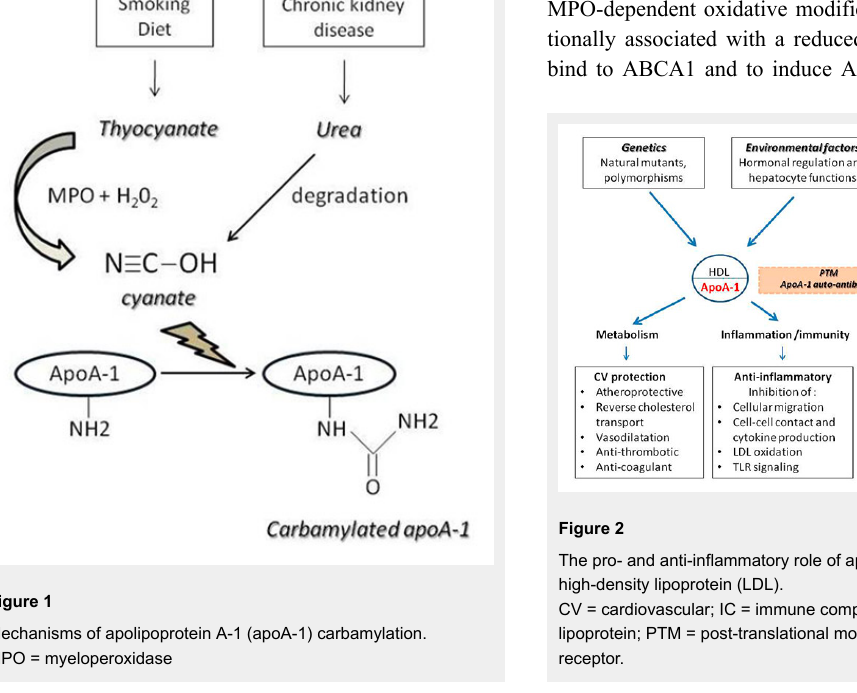
Mechanisms of apolipoprotein A-1 (apoA-1) carbamylation. MPO = myeloperoxidase